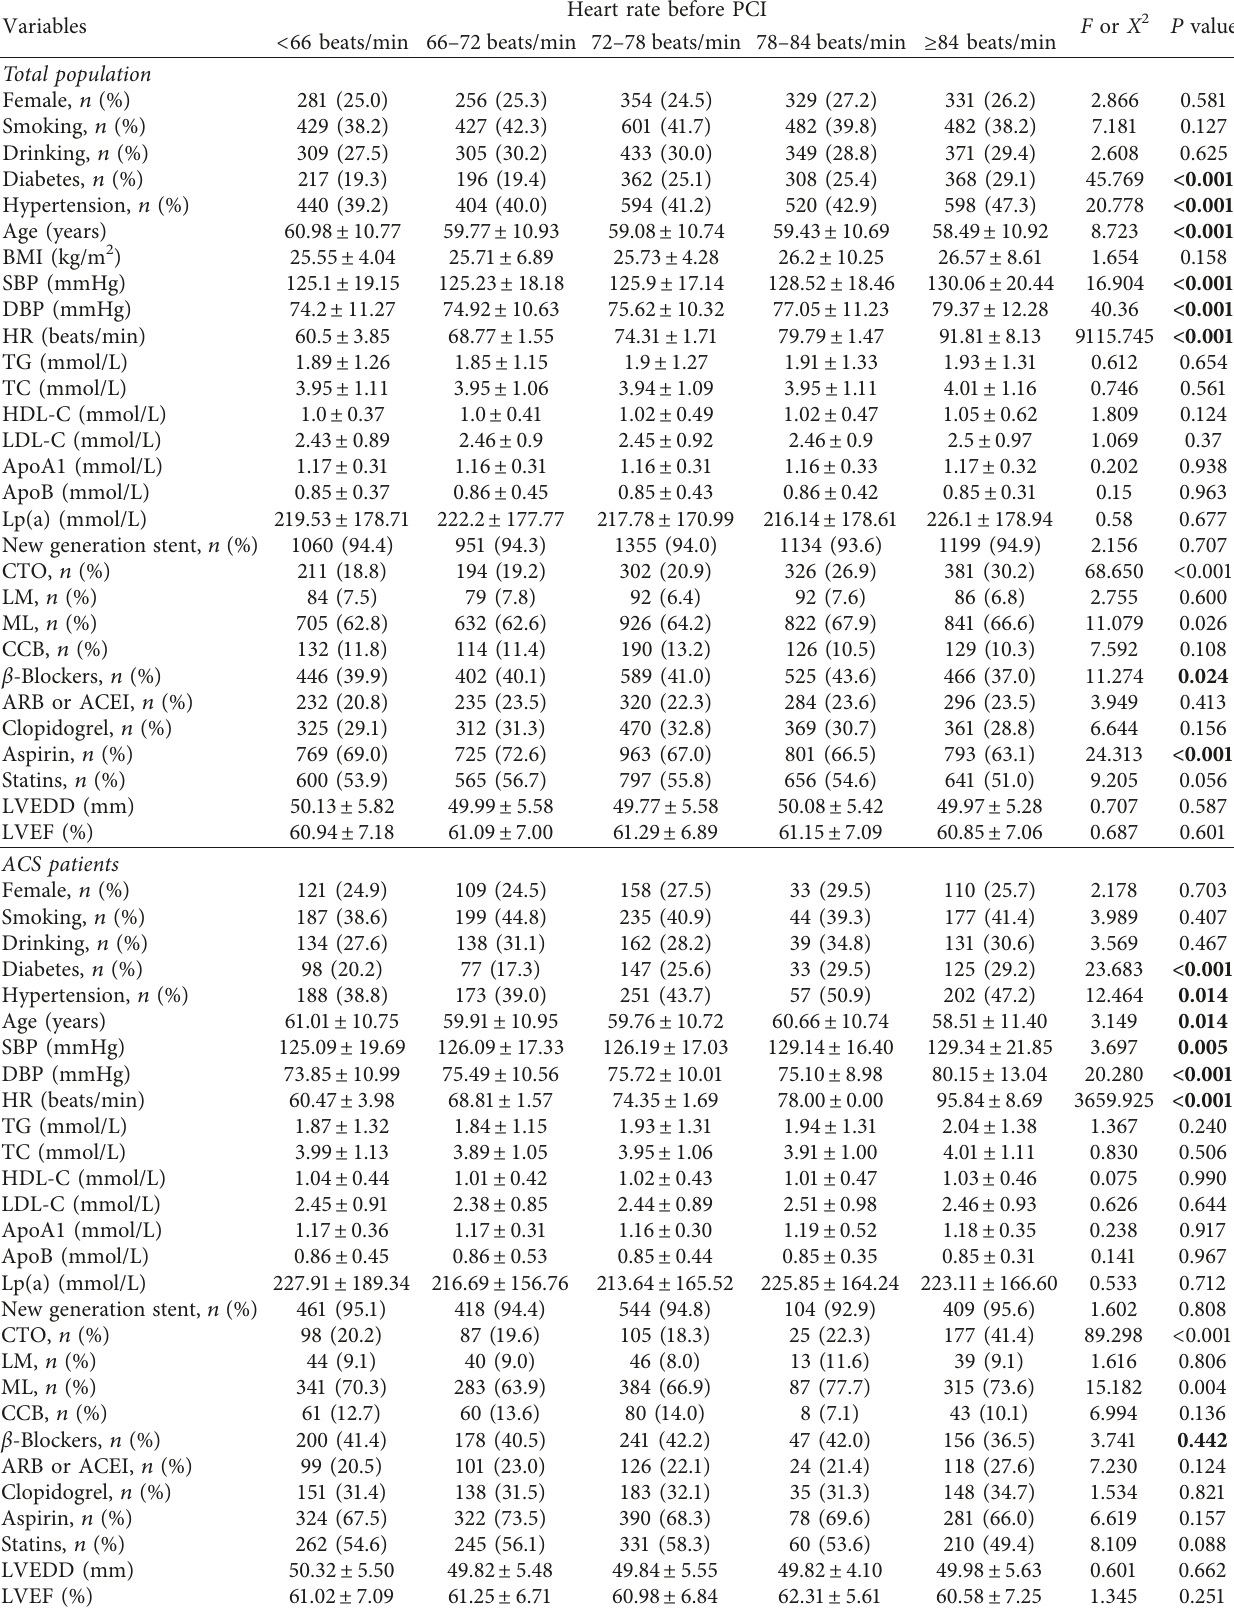
Table 1: Baseline characteristics of